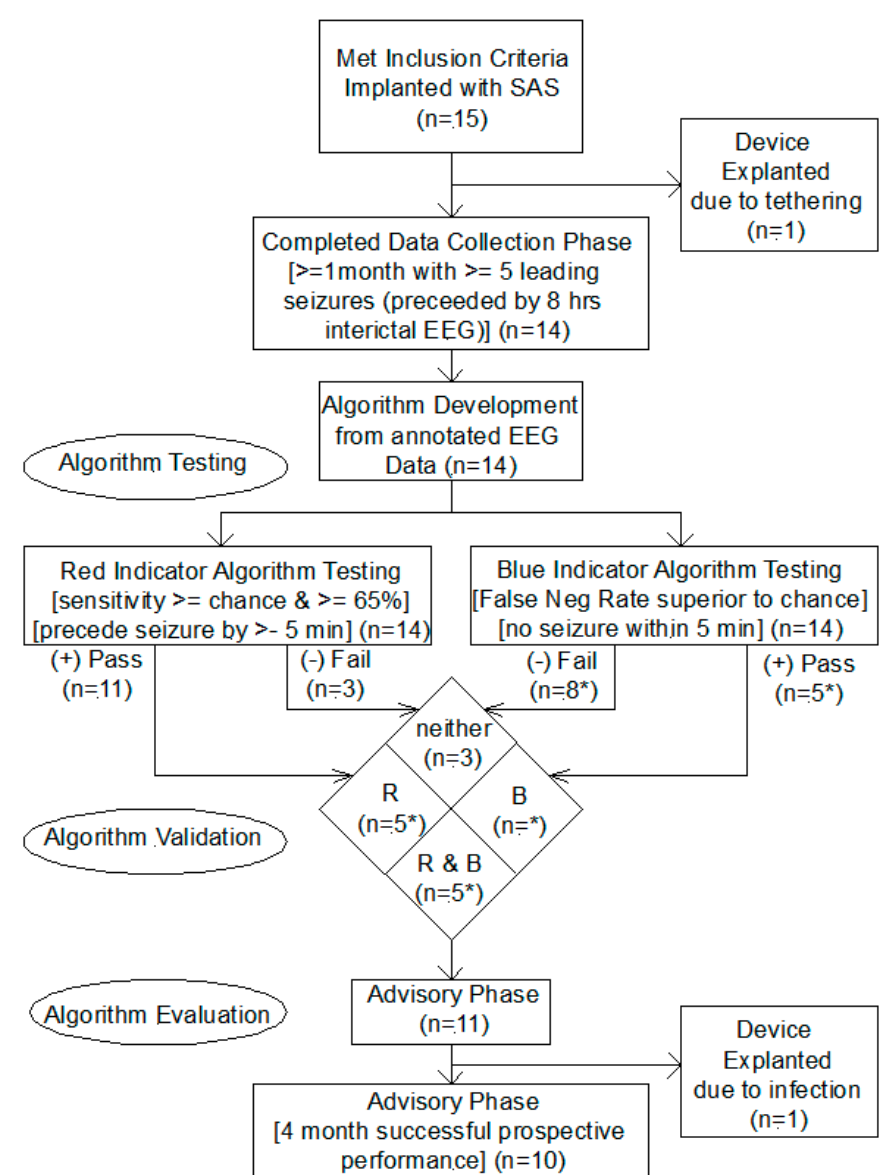
Figure 4. Study Design Flow Diagram: This represents the flow of the 15 patients who were implanted with an SAS through the Data Collection Phase, then through an algorithm testing and validation step, followed by algorithm evaluation in an Advisory